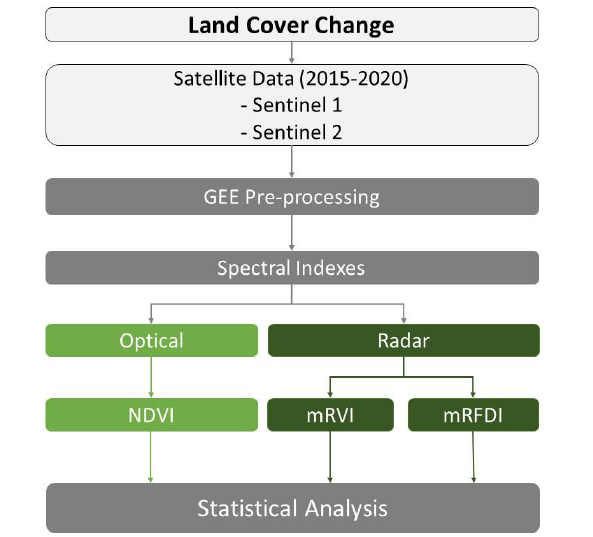
Figure 4. Flowchart of the